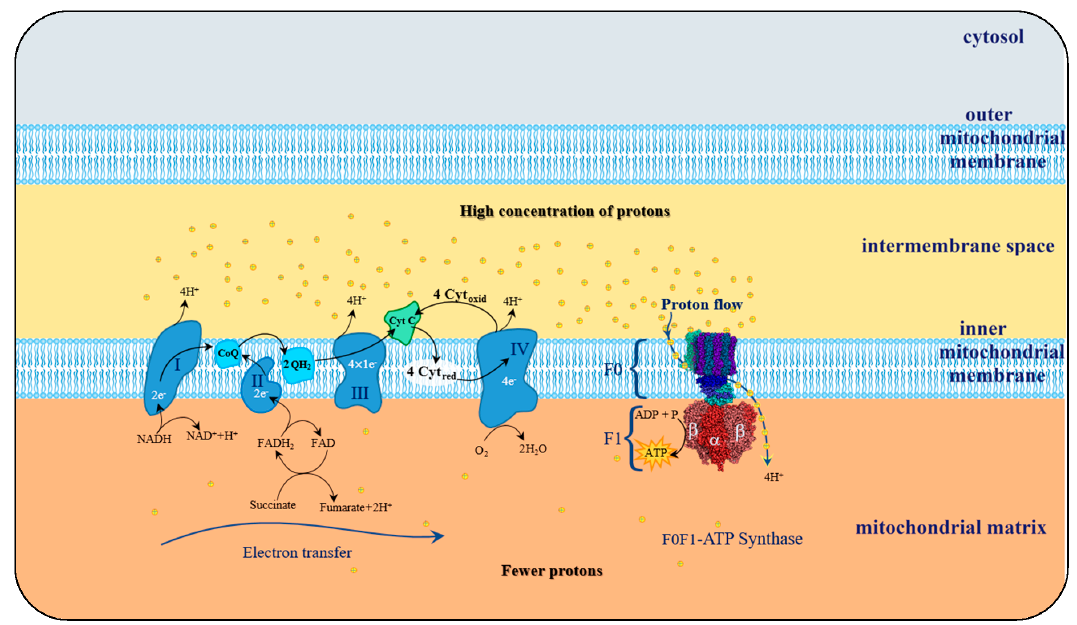
Figure 5. Mitochondrial respiratory metabolism. The electron transport chain has the main purpose of the creation of a transmembrane electrochemical proton gradient that will power the OP and ATP release. Electrons are transferred along the chain of protein complexes I to IV. Complex I-NADH dehydrogenase; complex II-succinate dehydrogenase; complex III-cytochrome c oxidoreductase; complex IV-cytochrome c oxidase; complex V-F1F0 ATP synthase.